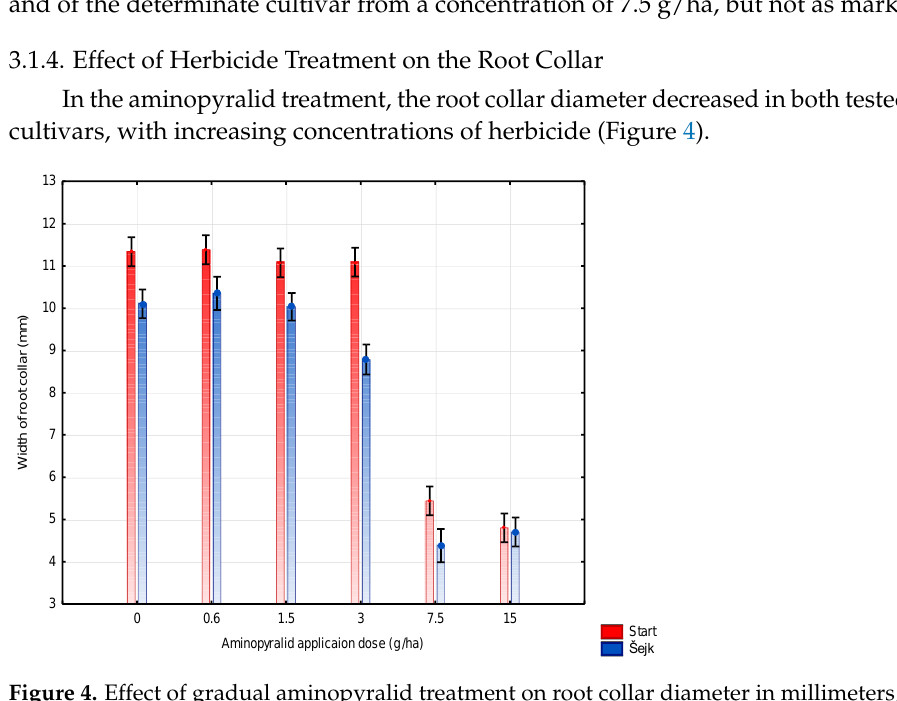
Figure 4. Effect of gradual aminopyralid treatment on root collar diameter in millimeters; ANOVA with Fisher´s LSD post hoc test (α = 0,05; n = 10), bar is a standard deviation, significantly different classes of values were added in separate Table S2 in Supplementary Materials.